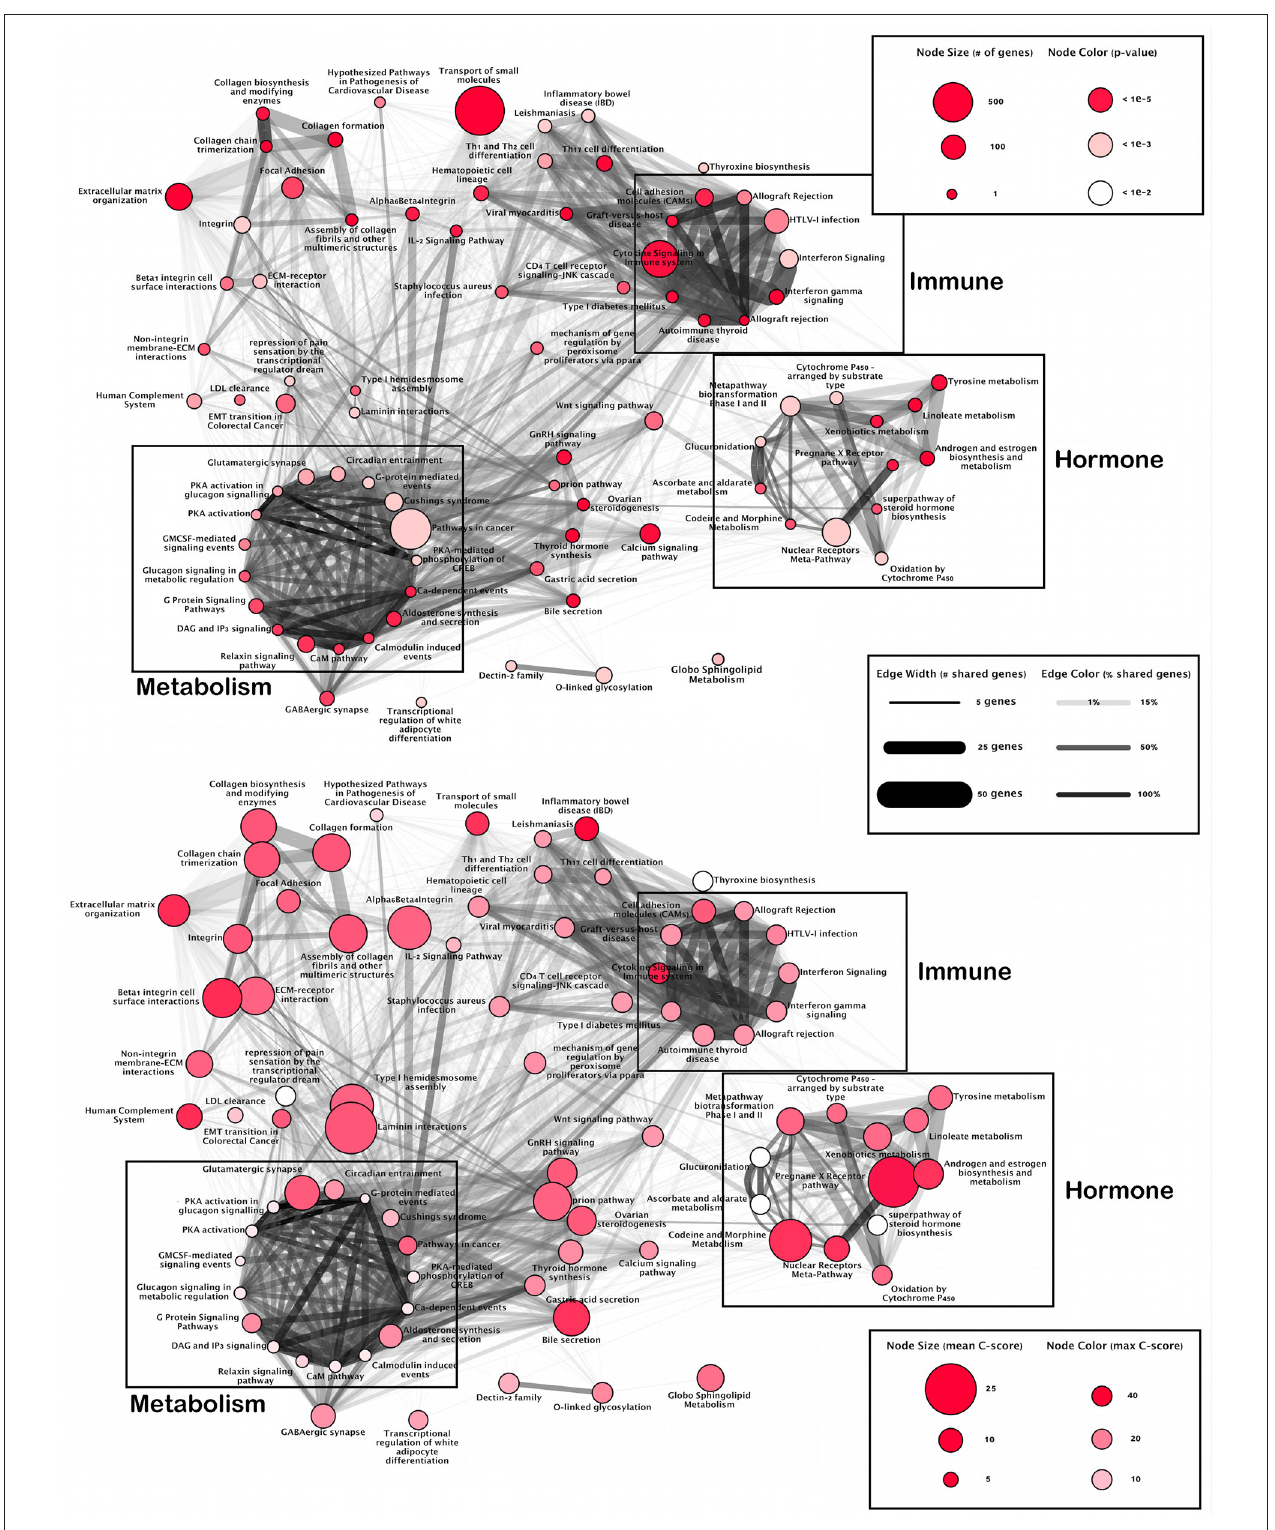
FIGURE 1 | Pathway overlap networks. Pathways identified via over-representation analysis (nodes) connected by shared genes with SNPs (edges). Upper panel gives total number of SNPs per pathway and likelihood of annotation ( p -value). Lower panel shows pathways most affected by deleterious SNPs.